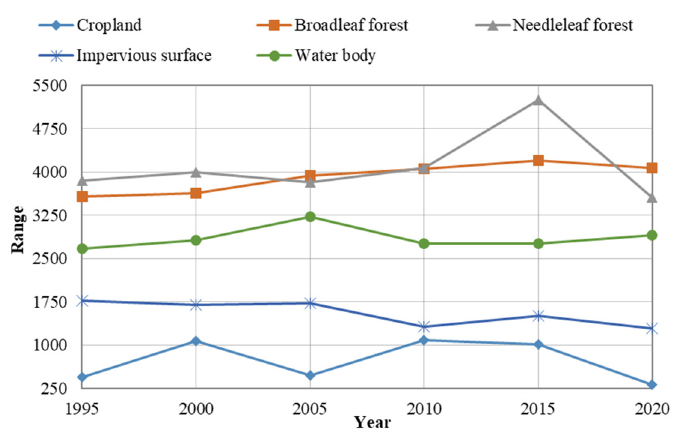
Figure 7. Range Parameters for Different Land Cover Types from 1995 to 2020.